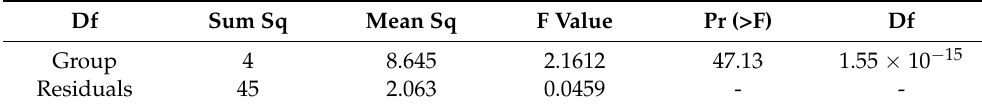
Table 3. One-factor ANOVA results.